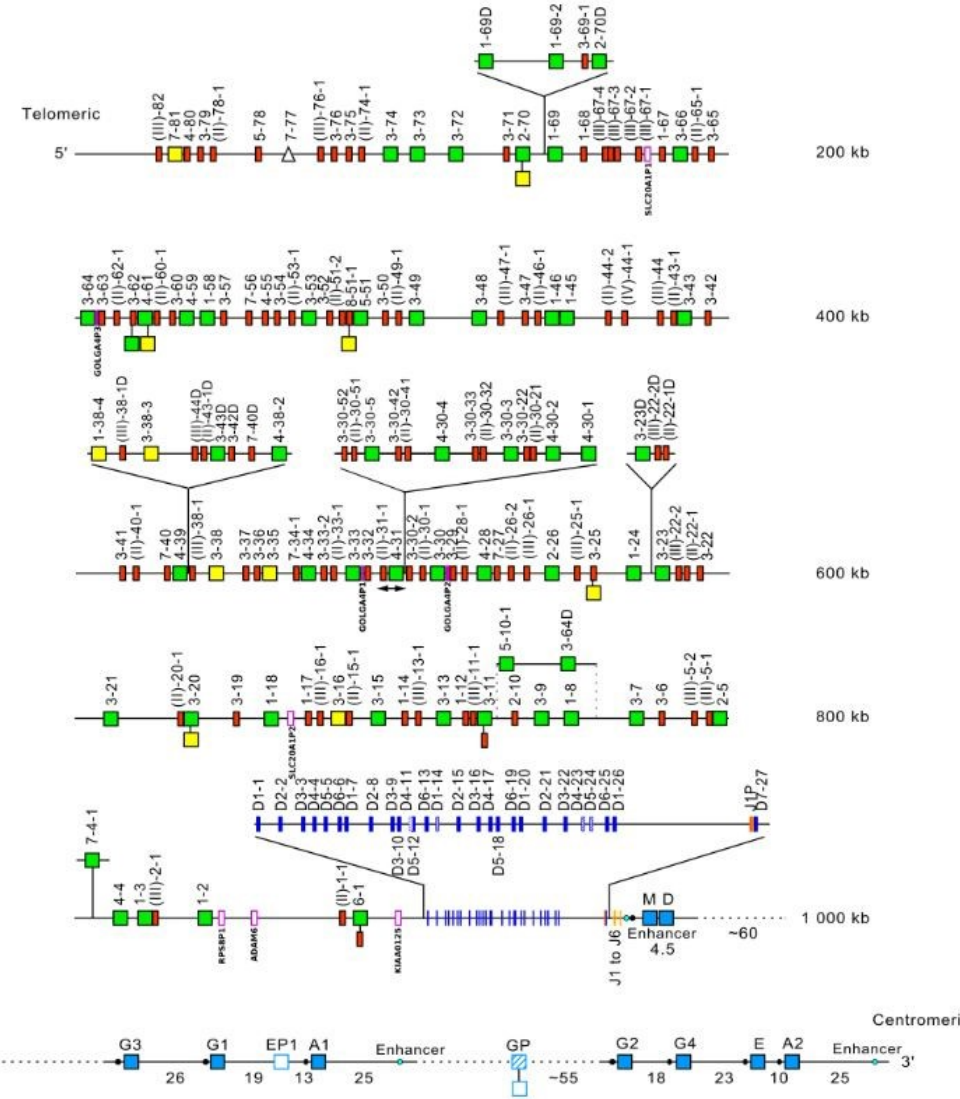
Figure 16. Representation of the human IGH locus at 14q32.33 [2]. The boxes representing the genes are not to scale. Exons are not shown. Switch sequences are represented by a filled circle upstream of the IGHC genes. Pseudogenes which could not be assigned to subgroups with functional genes are designated by a Roman numeral between parentheses, corresponding to the clans, followed by a hyphen, and a number for the localization from 3 ′ to 5 ′ in the locus [2]. (With permission from M ‐ P. Lefranc and G. Lefranc, LIGM, Founders and Authors of IMGT ® , the international ImMunoGeneTics information system ® , http://www.imgt.org).